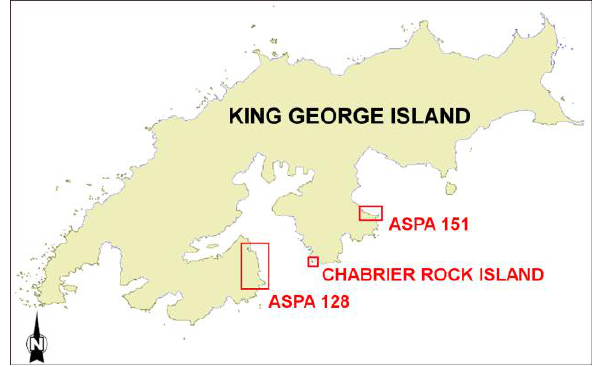
Figure 3. Investigated areas: Antarctic Specially Protected Areas (ASPA) no.128 and 151, as well as Chabrier Rock